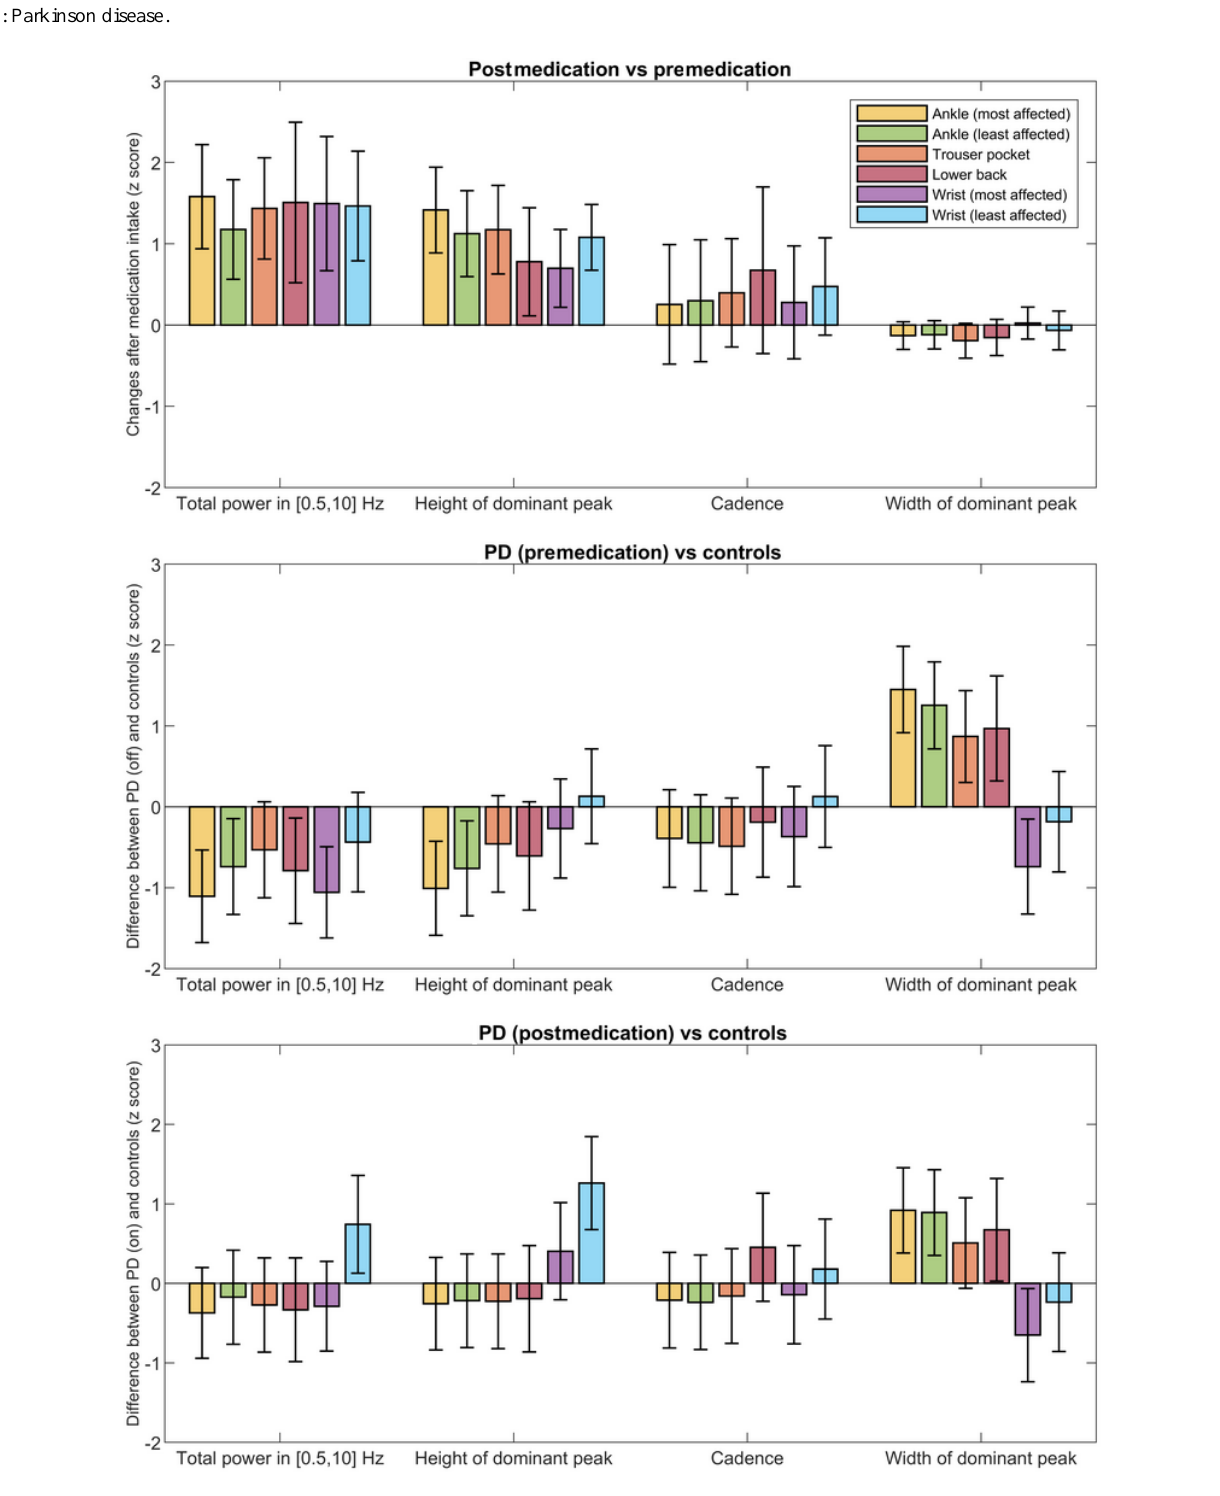
Figure 3. Top: changes after medication intake on a group level (mean and 95% CI). Middle: differences between patients with PD (premedication) and controls (mean and 95% CI, positive means higher in patients). Bottom: differences between patients with PD (postmedication) and controls (mean and 95% CI, positive means higher in patients). All estimates are based on linear mixed effects models for each sensor location and signal property. PD: Parkinson